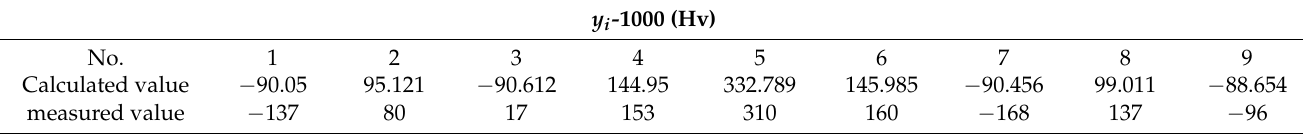
Table 8. Comparison of the calculated value with the measured value. y i - 1000